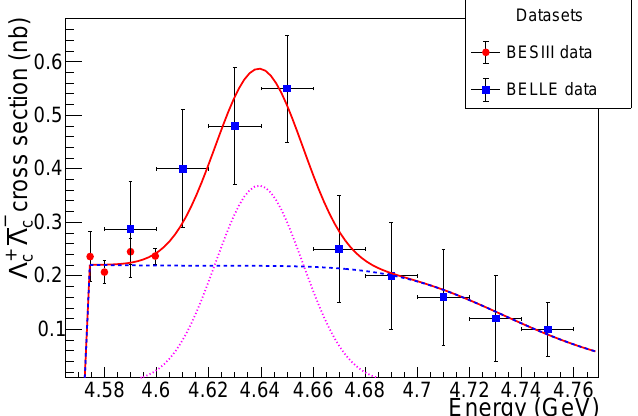
Figure 3. Fit to BESIII [11] and Belle data [6] close to the Λ + c ¯ Λ − c threshold with both resonant and non-resonant contributions. The red dots with error bars indicate the BESIII experimental data, the blue squares indicate the Belle data. The red line indicates the sum of the two contributions. The dashed blue line represents the non-resonant contribution of the fit, whereas the dotted magenta line represents the Breit–Wigner component. Both curves have arbitrary normalization. The first Belle data in [6] are not presented in the plot, as discussed in the